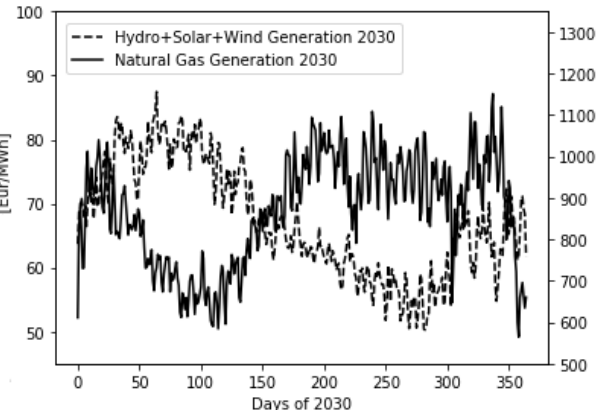
newables) for 2030 in MIBEL.